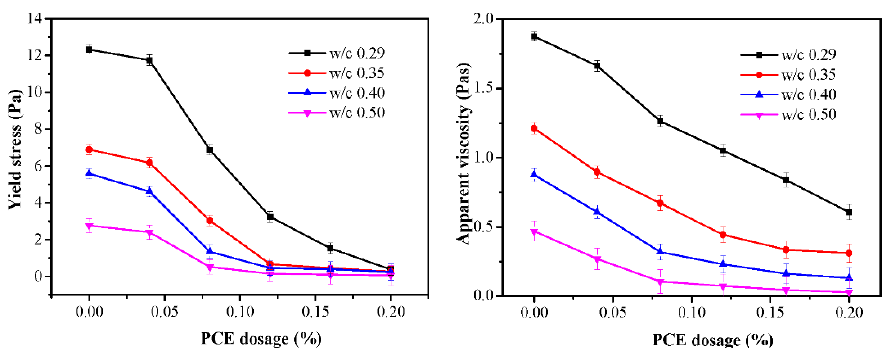
8 of 18 Figure 5. WFT versus PCE dosage for pastes with various w/c ratios. 3.3. Rheology The results of the yield stress and apparent viscosity are plotted against the PCE dos- ages for different w/c ratios in Figure 6. It can be seen that apparent viscosity decreased as the PCE dosages increased, thereby drastically reducing yield stress. In addition, the effects of the PCE on the yield stress and apparent viscosity of the fcps were dependent on the w/c ratio. As the w/c ratio increased, the marked difference in the yield stress and apparent viscosity of the fcps prominently decreased. For the w/c = 0.29 fcps, the yield